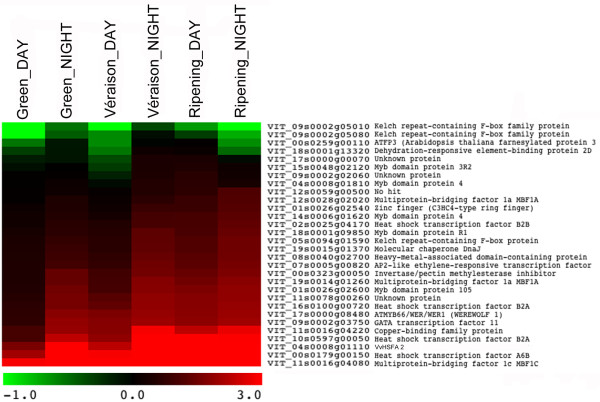
Expression matrix of MBF1c regulon transcripts from Arabidopsis thaliana identified in NimbleGen 090818 Vitis 12X microarrays. Scale is in log2 change between control and heat treatment.